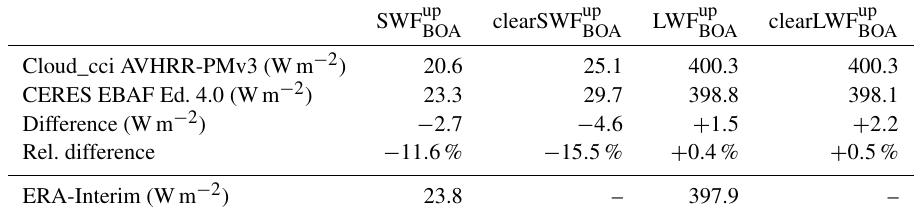
Table 9. As Table 8 but for BOA upwelling broadband